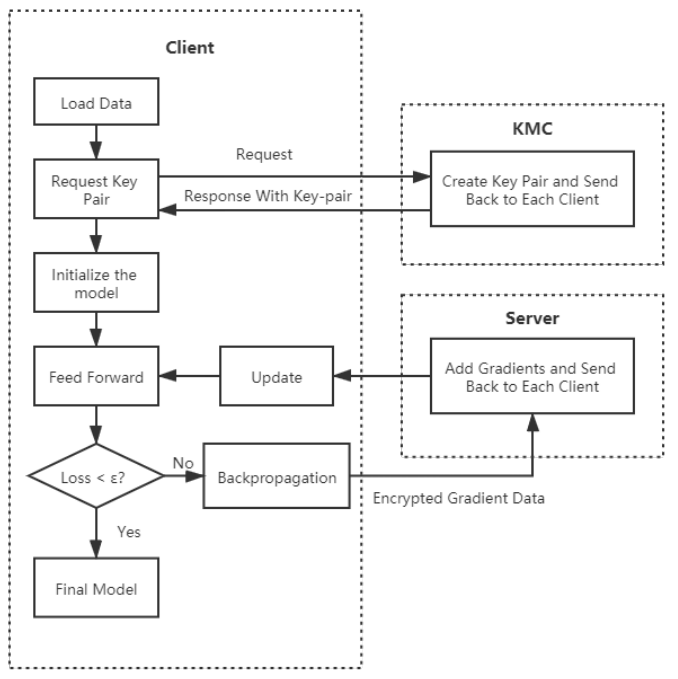
Figure 4. The architecture of a Paillier federated